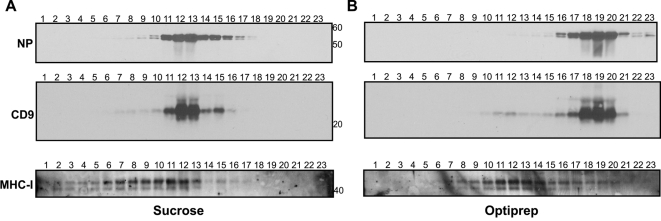
Gradient fractionation demonstrates co-purification of influenza virus and CD9.Influenza A/WSN/33 virus was purified over (A) sucrose and (B) Optiprep gradients. Fractions were taken from the top and analyzed by western blot for the presence of NP, CD9 and MHC-I, as indicated. Numbers to the right are molecular weight markers.